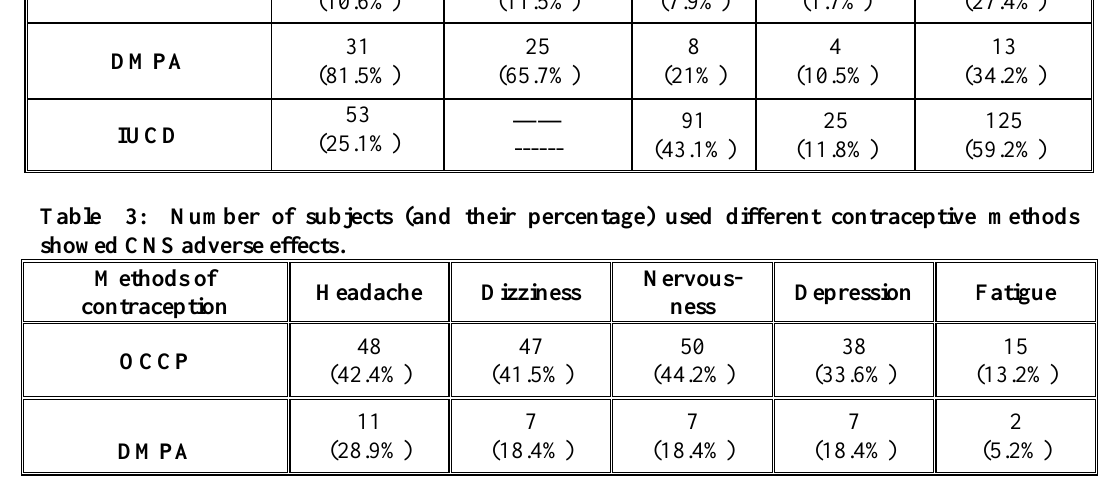
Table 4 : Number of subjects (and their percentage) used different contraceptive methods showed GI adverse effects Methods of